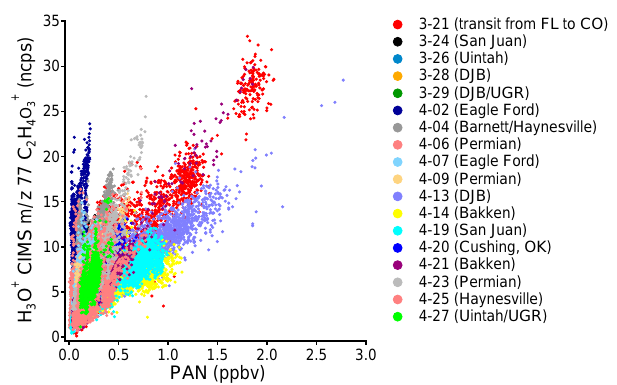
Figure 12. Relationship between m/z 77.023 C 2 H 4 O 3 H + mea- sured by H 3 O + ToF-CIMS and